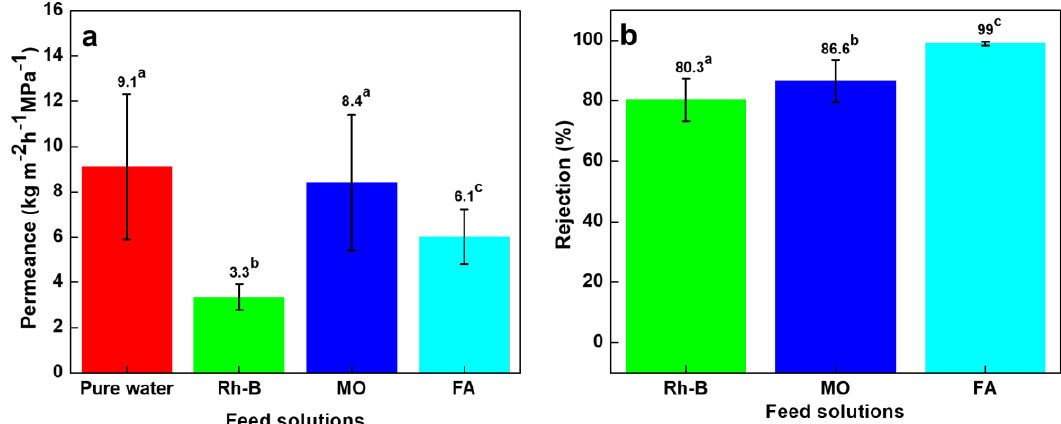
Figure 7. Nonwoven/PVDF-PAA/GO membrane filtration performance: ( a ) permeance and ( b ) rejection values for Rhodamine B, methyl orange (both 10 ppm) and 500 ppm folic acid solutions. Data with different letters are significantly different at 5% significance level. The permeance of pure water is included for comparison.